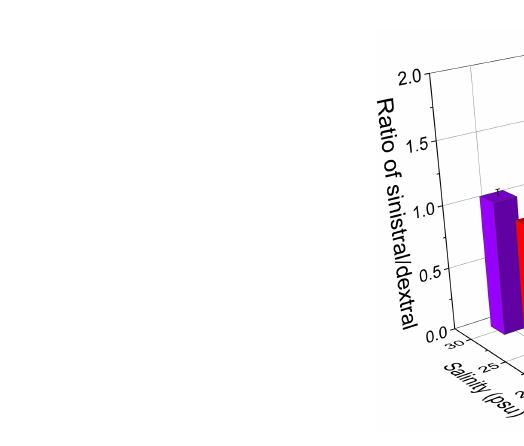
FIGURE 4 Ratio of sinistral/dextral in A. aomoriensis under different temperature and salinity in the culture